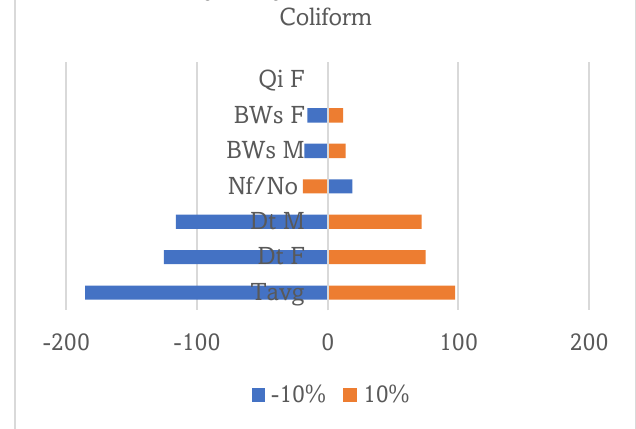
Fig. 5. Sensitivity analysis for Ne (effluent fecal coliforms)